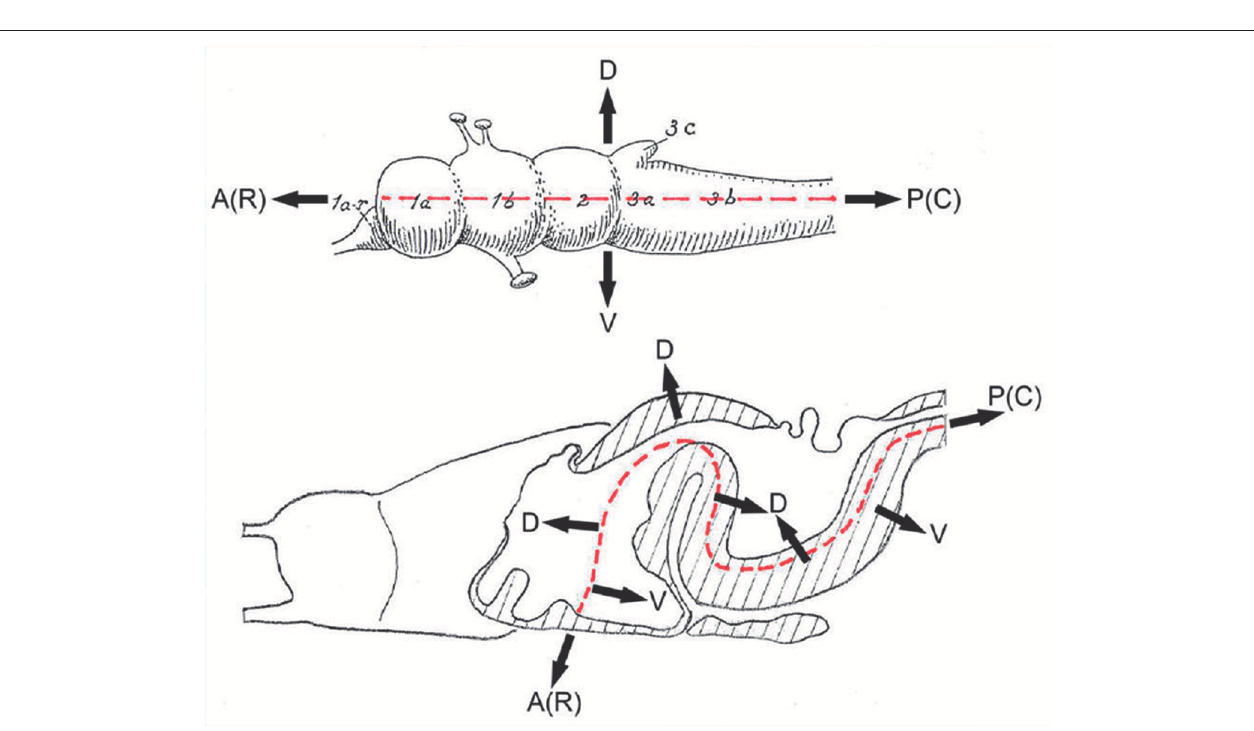
FIGURE 3 | These two schemata are copied from Nieuwenhuys and Puelles (2016) (plate 50) (no copyright permission required). They highlight the crucial difference in the axial morphological reference for the brain used by columnar authors as compared to neuromeric authors following His (1893). The upper columnar schema was drawn by Ranson (1928), and it pretended to illustrate how the length axis of a primitive brain (red dashes) passes straightly through the telencephalon (1a), the diencephalon (1b), the midbrain (2), and the hindbrain (3a,3b; 3c is the cerebellum). The tags A(R) and P(C) refer to anterior (rostral) and posterior (caudal), respectively. D and V mark the orthogonal dorsoventral dimension. Remarkably, the cephalic flexure is not represented, though it appears in all vertebrates (an instance of psychological negation). The lower schema represents a gymnophionan (amphibian) brain whose cephalic flexure is extremely marked. The length axis (red dashes) is marked according to prosomeric tenets following the observable curvature and ending behind the optic chiasma (the telencephalon is understood as a dorsal outgrowth of the hypothalamic alar plate). As in the upper schema, the AP course of the axis decides what is dorsal (D) or ventral